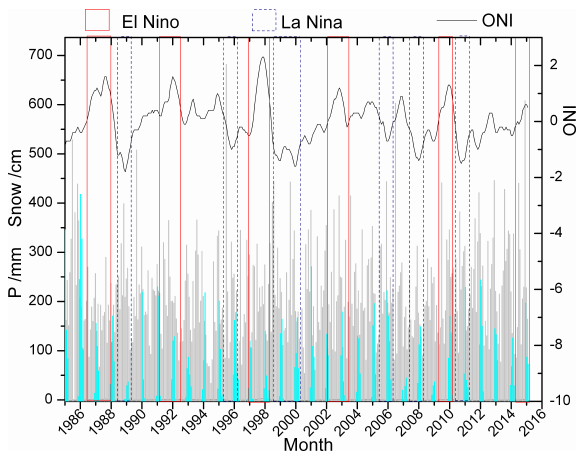
Figure 4. Rainfall (P), snowfall (Snow), Oceanic Niño Index (ONI), and El Niño and La Niña events.